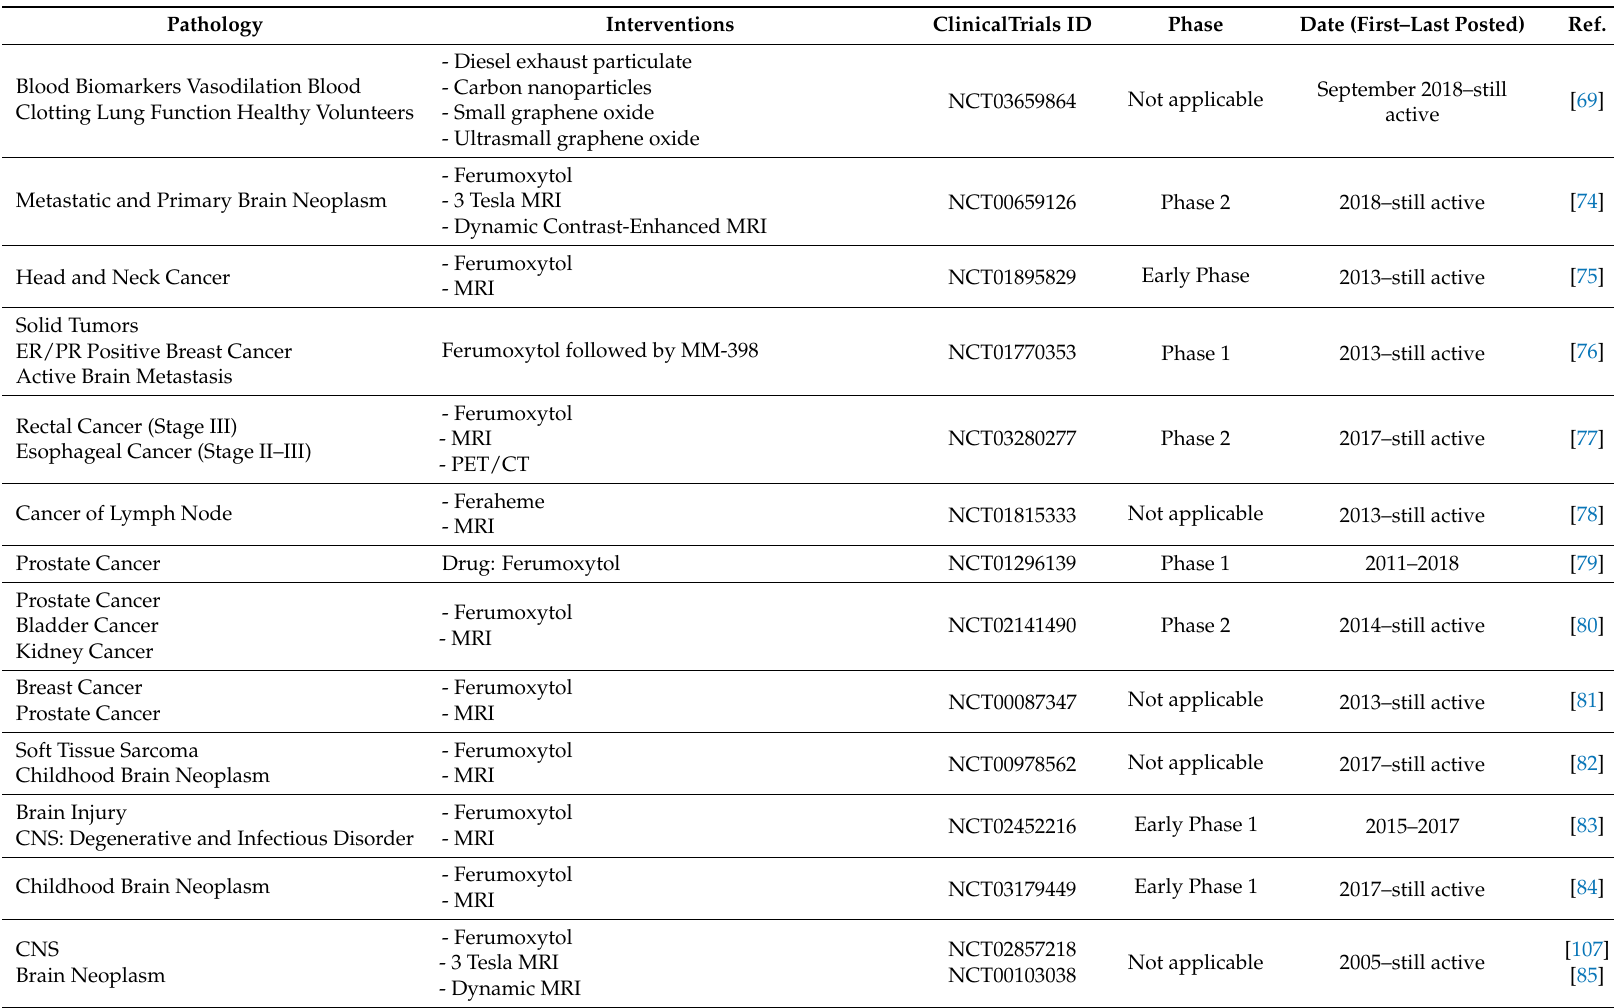
Table 2. Current clinical trials of thermosensitive nanomaterials for diagnosis of various diseases available on clinicaltrials.gov up to November 2018.